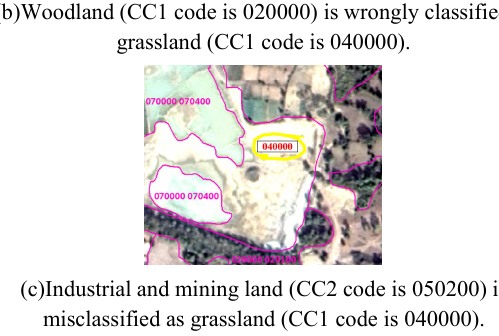
Figure 6 . The image does not support classification as grassland.